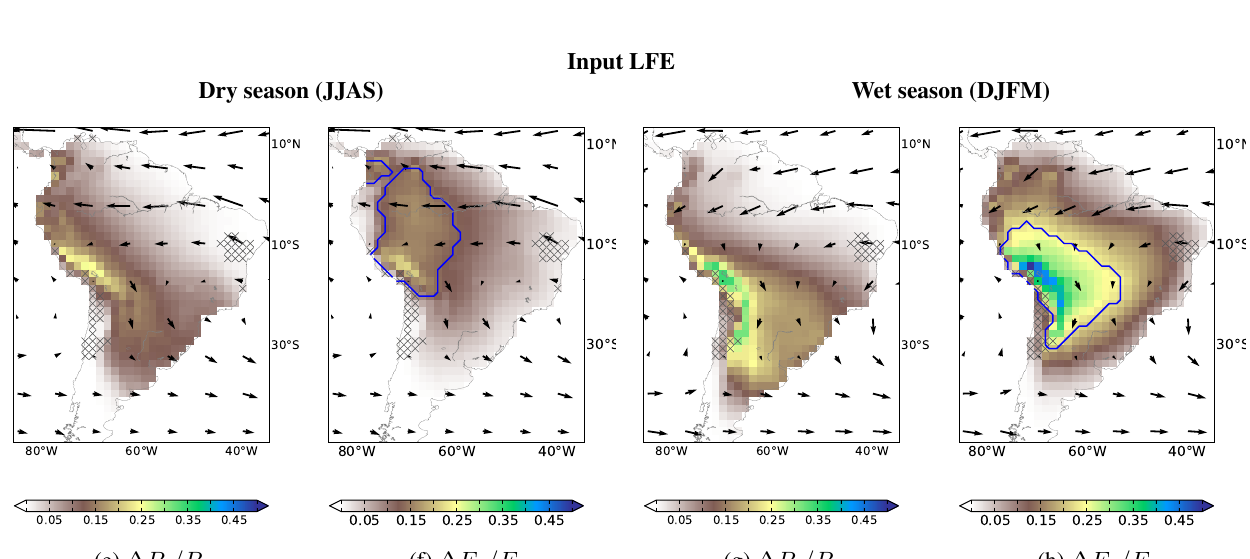
0.05 0.15 0.25 0.35 0.45